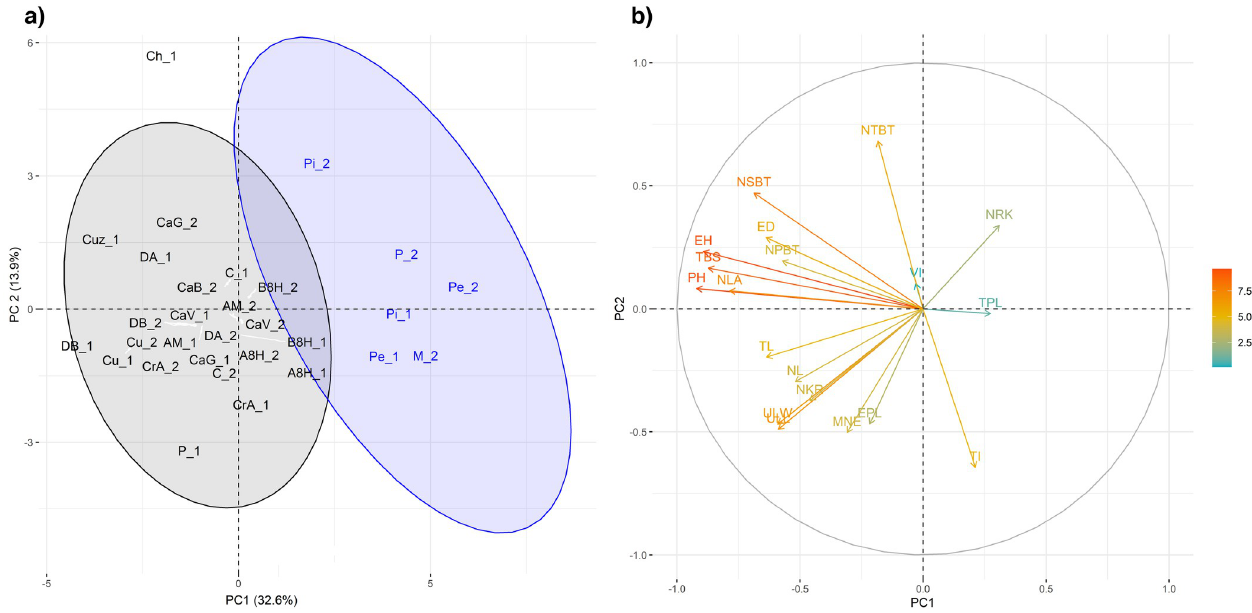
Fig 2. Principal Component Analysis based on 19 agro-morphological traits. (a) Scatter plot of PC1 vs. PC2. Accessions are color-coded according to the groups identified by the K-means procedure. (b) Correlations and variable contributions to the first two PCs.